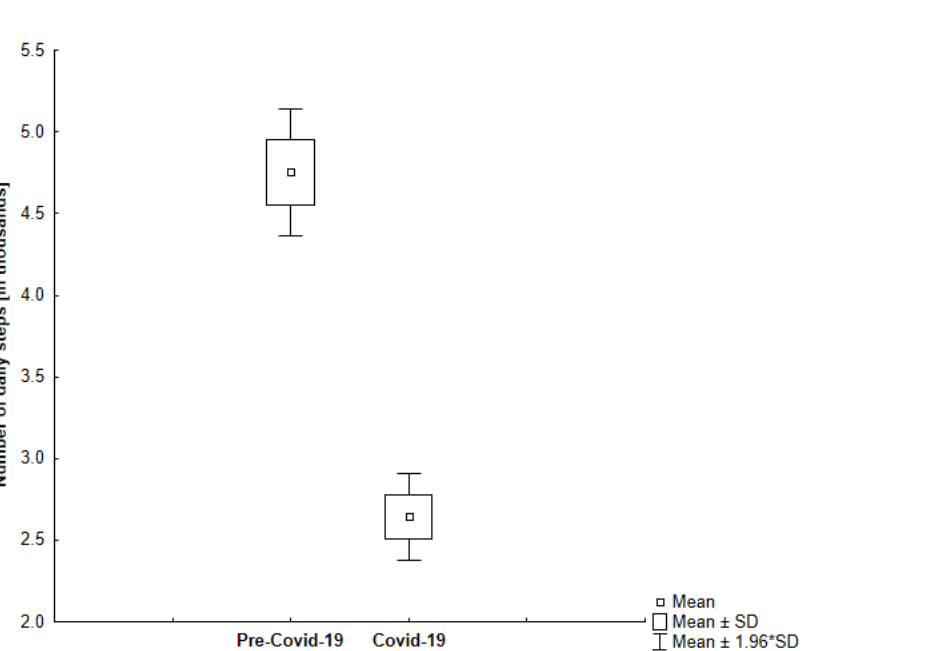
Figure 4. The comparison of the number of daily steps in the analyzed periods among older partic- ipants ( p < 0.001).